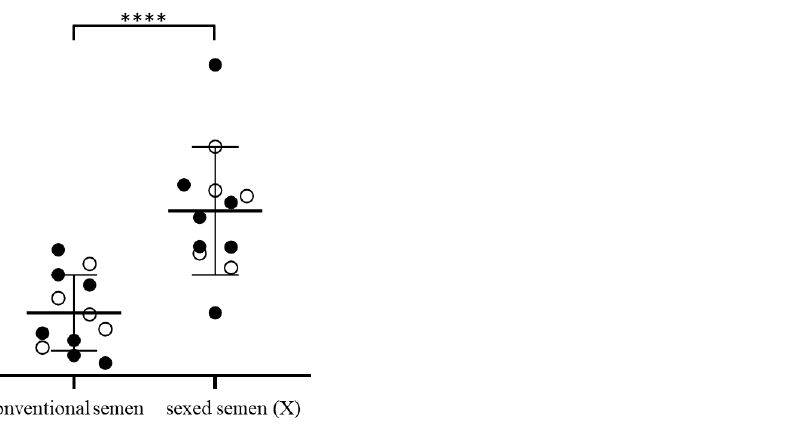
Figure 2. GAPDHS enzymatic activity in spermatozoa from frozen-thawed samples of sexed (X spermatozoa) and conventional bovine sperm derived from the same bull (white circles) or from different animals (shown with black dots). **** p -value < 0.0001. The bold line corresponds to the mean value and error bars indicate standard deviation.